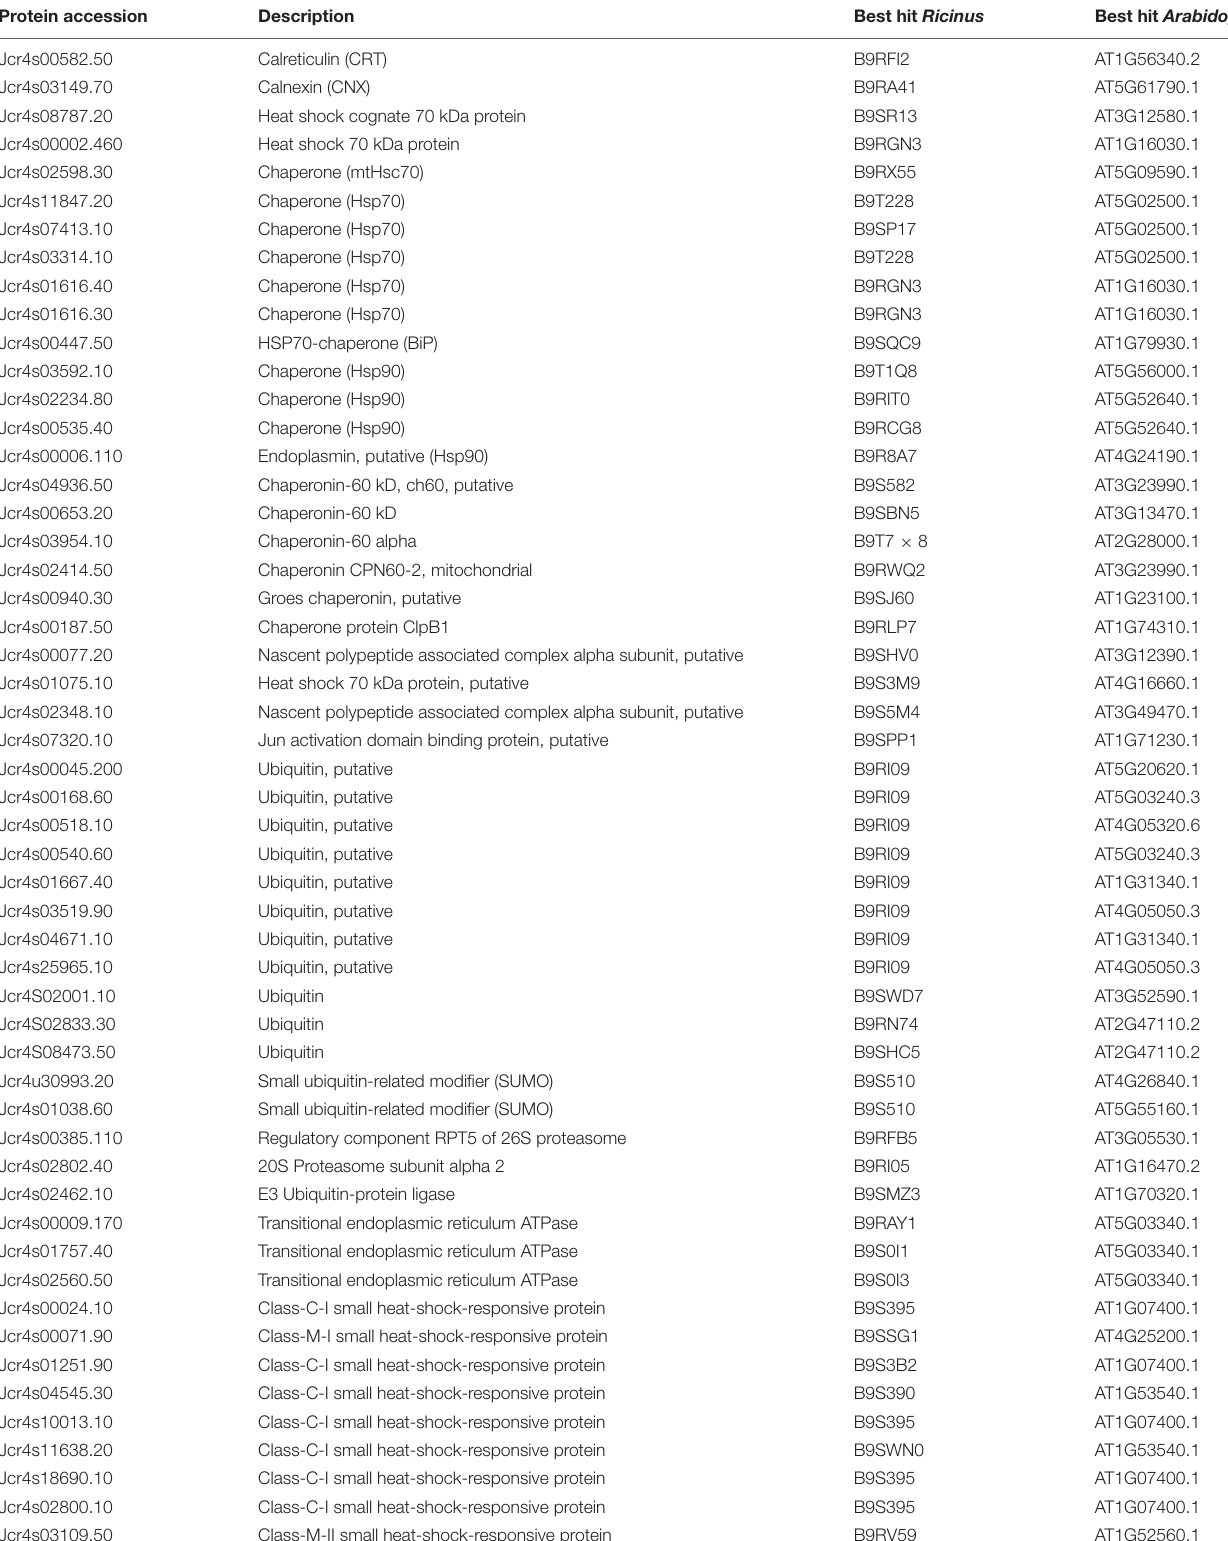
TABLE 3 | Proteostasis and defense related proteins identified from the embryo of mature J. curcas seeds. Protein accession